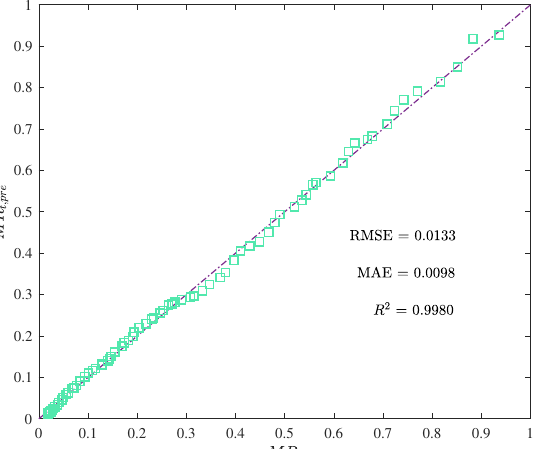
Figure 12. The moisture ratio predicted by the ANN model MR t , pre vs. the actual moisture ratio MR t .